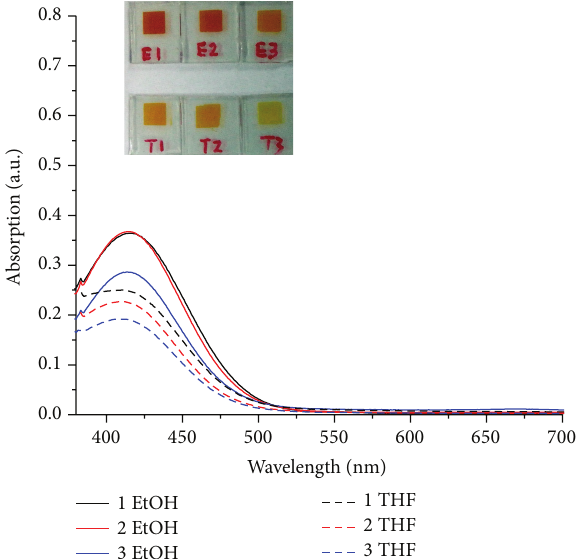
Figure 3: UV-vis absorption spectra of PT1–3 dyes extracted from the surface of TiO 2 film in EtOH and THF.